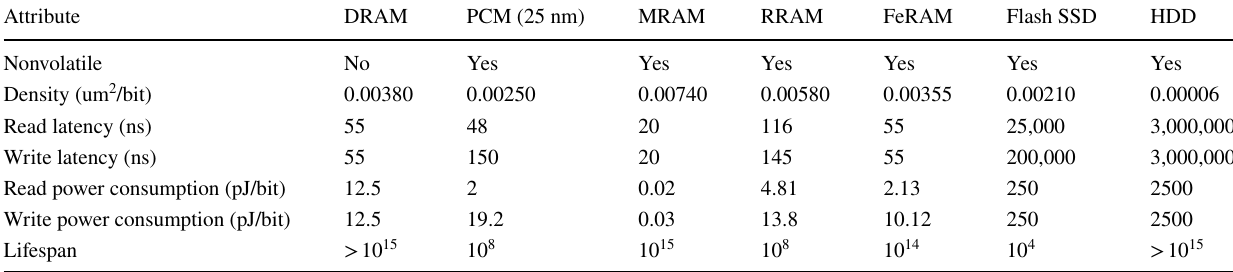
Table 2 Performance metrics of different storage